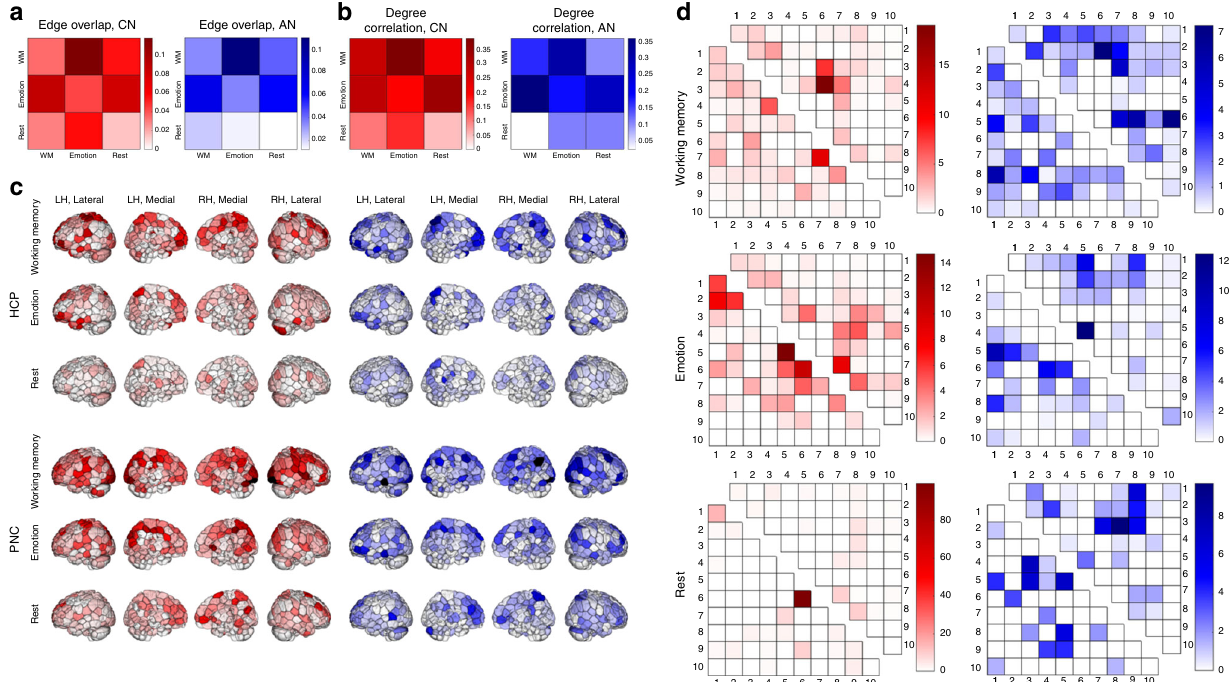
Fig. 2 Model connections are widely distributed throughout the brain and demonstrate substantial overlap between models. a Edge overlap (number of shared edges normalized by the total number of unique edges in the models) between each pair of models within (off-diagonal) and between (main diagonal) data sets. In these and all subsequent matrix visualizations, HCP data are presented in the bottom triangle and PNC data are presented in the upper triangle. CN, correlated network; AN, anti-correlated network. b Spearman ’ s correlation of node degree between each pair of models both within (off-diagonal) and between (main diagonal) data sets. c Visualization of node degree for each model in the HCP (top three rows) and PNC (bottom three rows) data. CN degree is displayed in warm colors; AN degree is displayed in cool colors; darker color indicates higher degree. LH, left hemisphere; RH, right hemisphere. d Canonical networks that contribute disproportionately (i.e., value > 1; see main text) to each model. As in a and b , HCP models are represented in the lower triangles and PNC models in the upper triangles. Each number corresponds to one canonical network (Methods): 1 = medial frontal, 2 = frontoparietal, 3 = default mode, 4 = motor cortex, 5 = visual A, 6 = visual B, 7 = visual association, 8 = salience, 9 = subcortical, 10 = cerebellum. Models in a – c were generated with an edge-selection threshold of P < 0.01; models in d were generated with an edge-selection threshold of P < 0.001 for improved visualization and interpretability NATURE COMMUNICATIONS| (2018) 9:2807 |DOI: